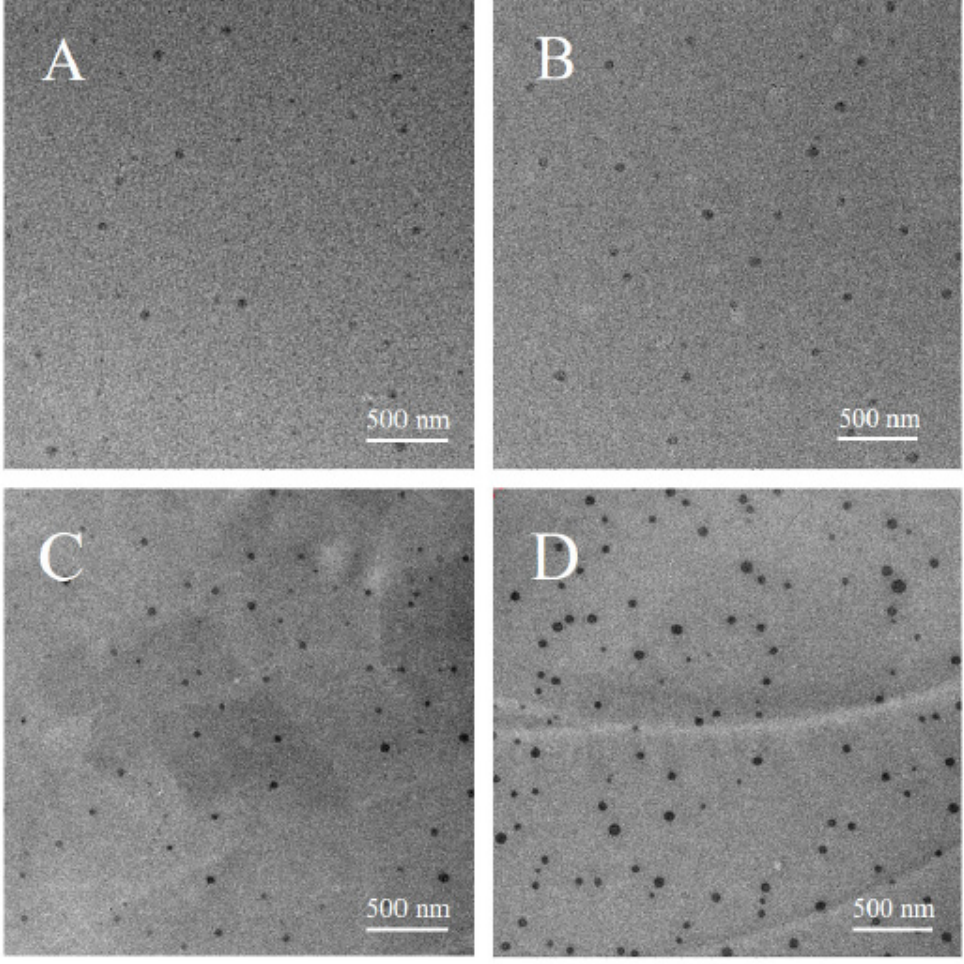
Figure 5. TEM images of: ( A ) PHU-POSS5; ( B ) PHU-POSS10; ( C ) PHU-POSS15 and ( D )